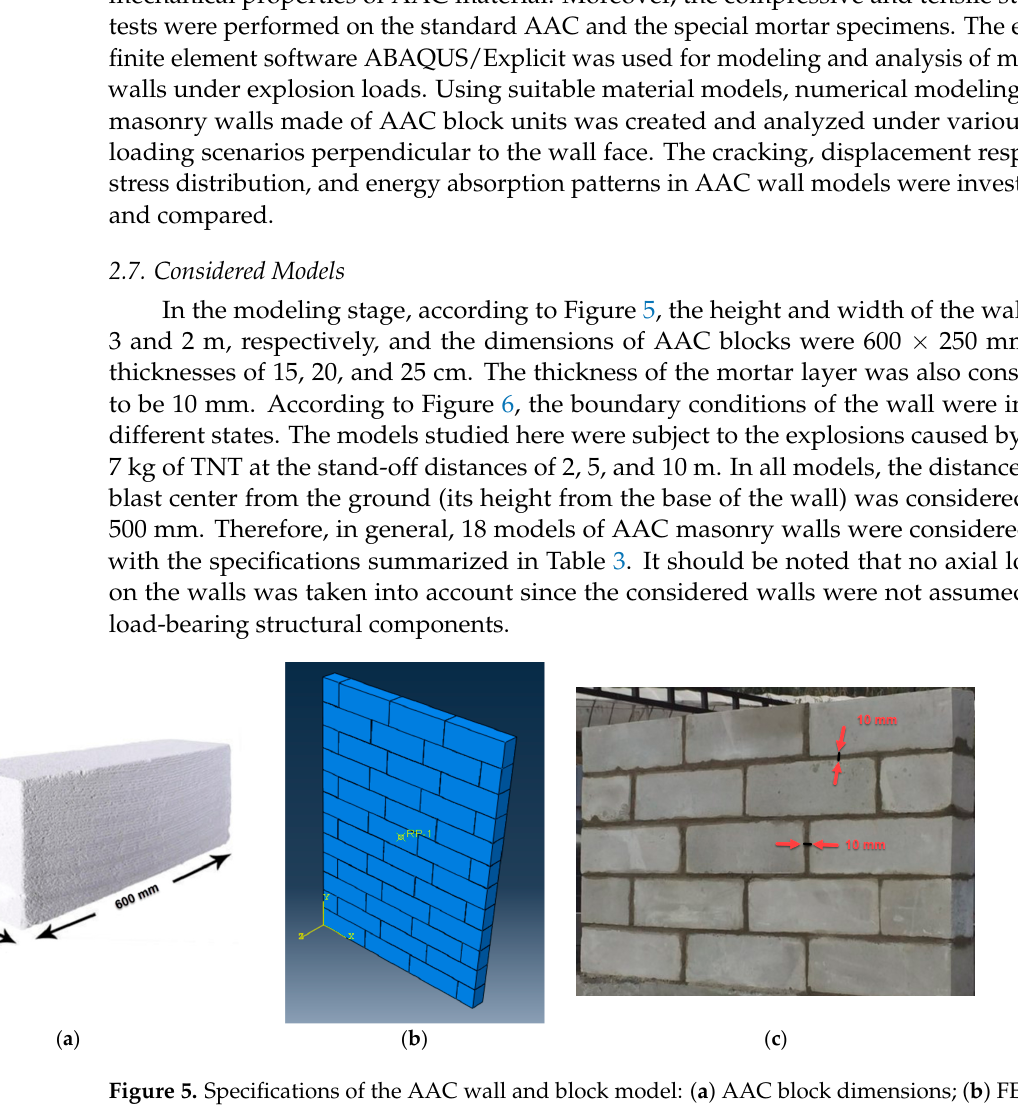
(c) Figure 6. Boundary conditions of the walls: ( a ) fixed top and bottom of the wall; ( b ) fixed sides and bottom of the wall; ( c ) fully fixed BCs. Table 3. Details of the studied models. Scaled Distance (m/kg 1/3 ) Charge Weight (kg) Stand-Off Distance (m) Thickness (cm) Model